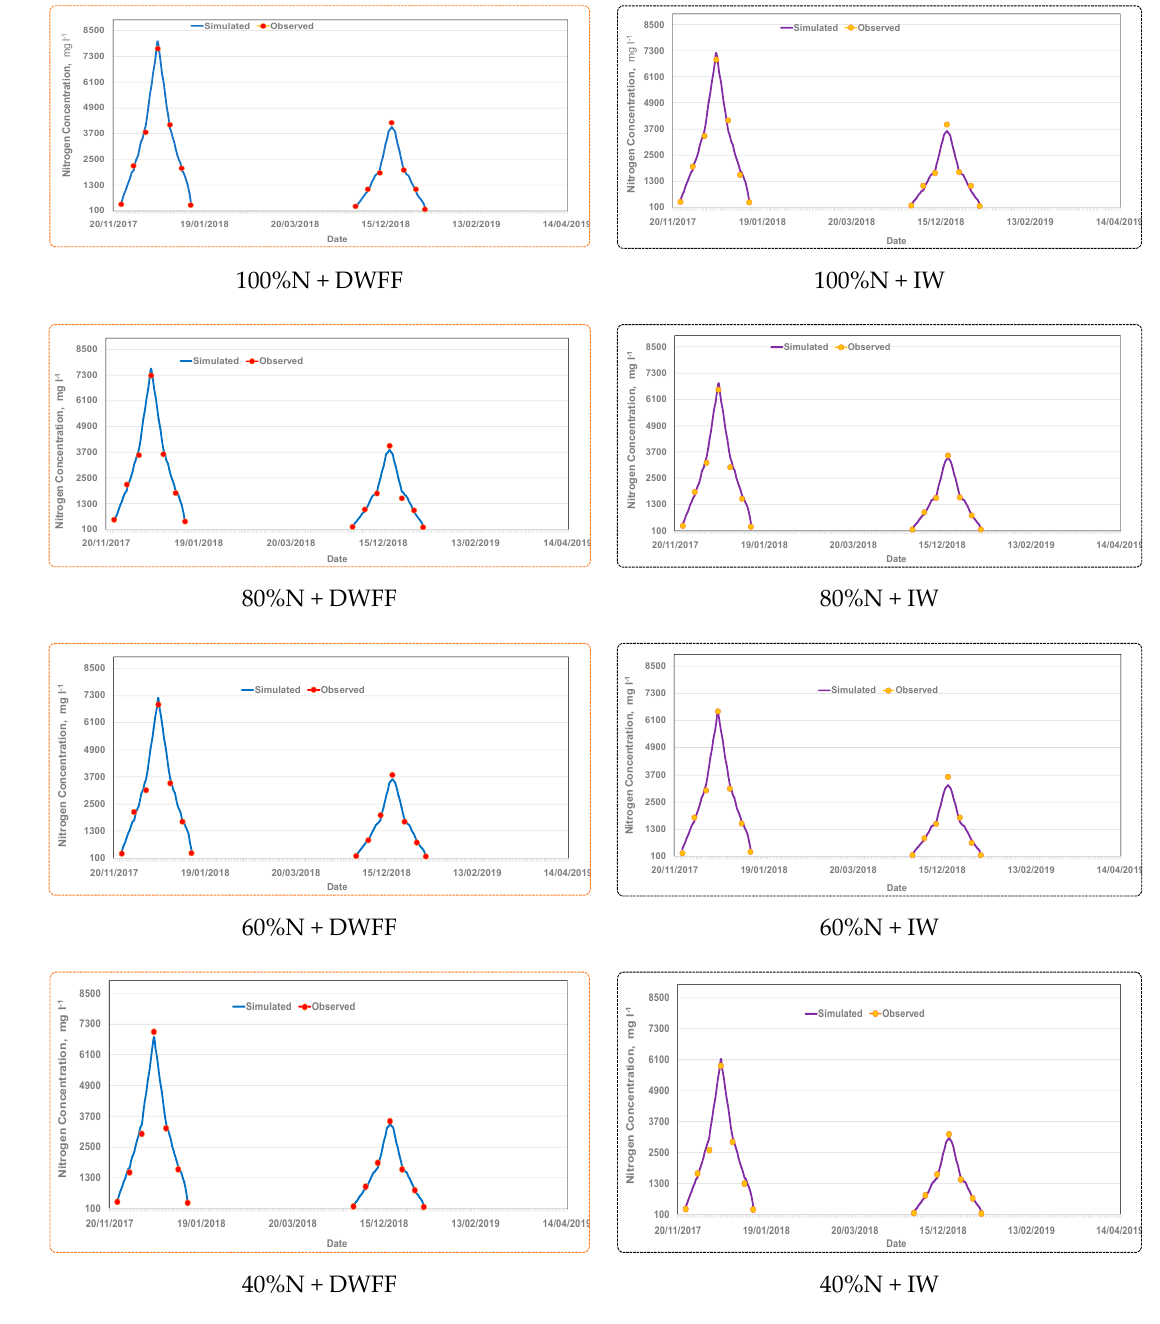
Figure 9. Observed and simulated nitrogen concentration of the soil layer for all treatments during the 2017/2018 and 2018/2019 seasons for different treatments:drainage water from fish farms (DWFF), fresh irrigation water (IW) and nitrogen (N).